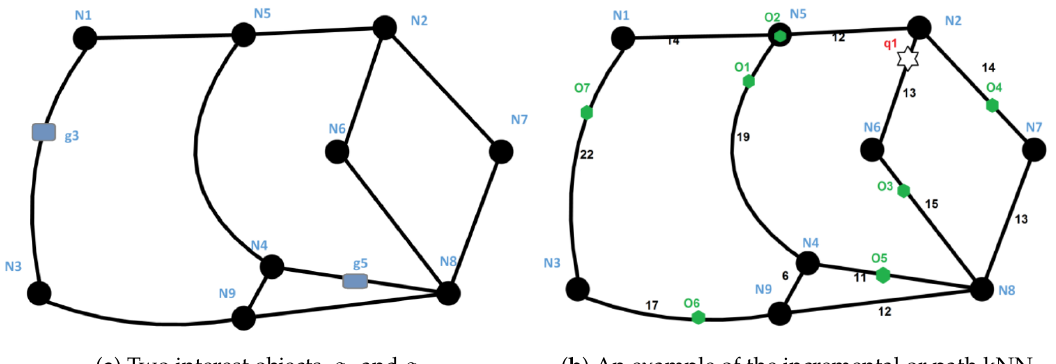
Figure 4. Shortest network distance and Incremental kNN